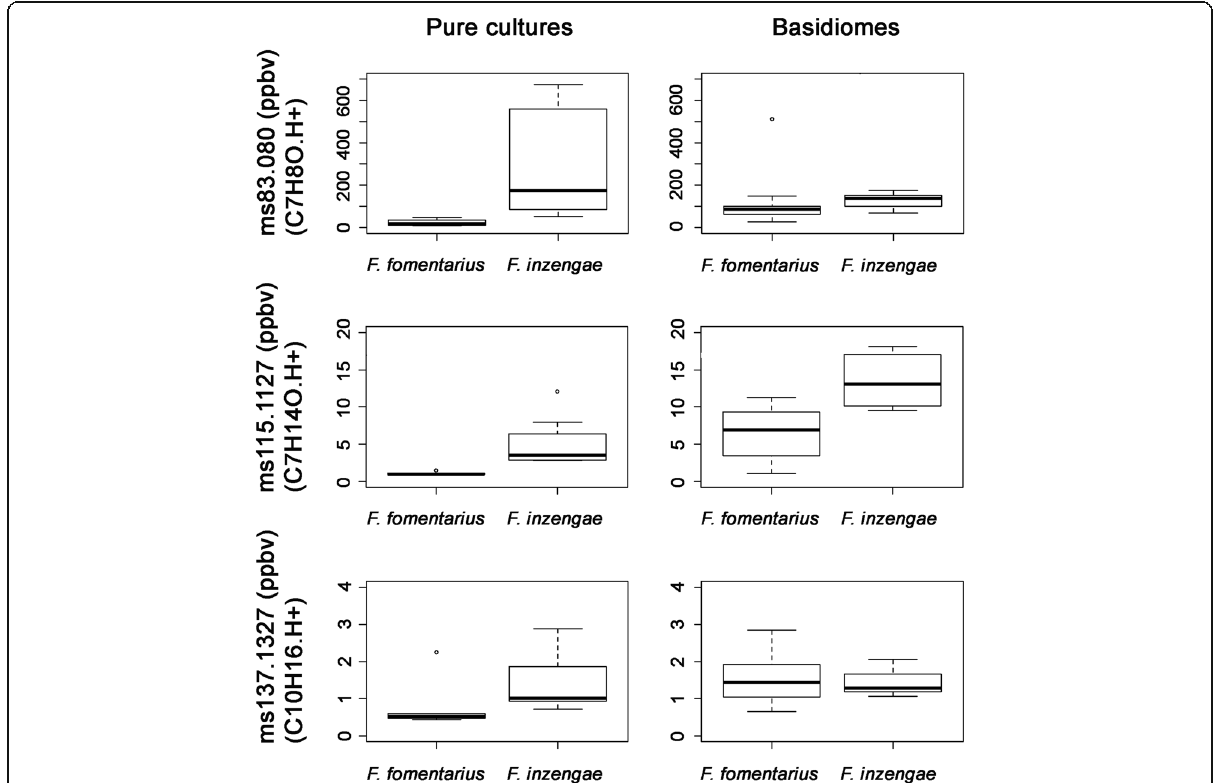
Fig. 9 Three exemplar mass peaks with significantly different concentrations between Fomes inzengae and F. fomentarius : C4H8O.H+ (protonated butanal/butanone), C7H14O.H+ (protonated heptanal/heptanone) and C10H16.H+ (protonated monoterpenes) Pure culture samples had always better separation in VOCs concentration than basidiomes. The interaction with the substrate increases VOCs emission in F.